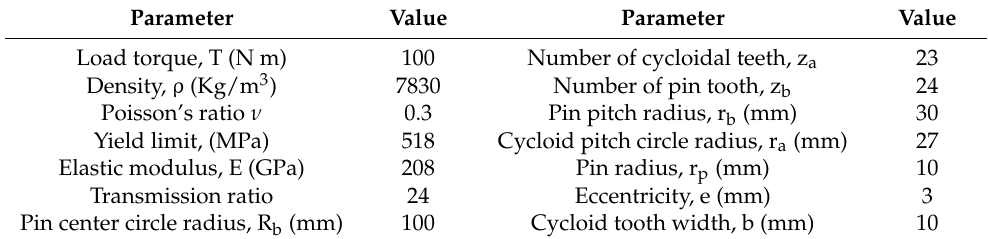
Table 2. Cycloid design